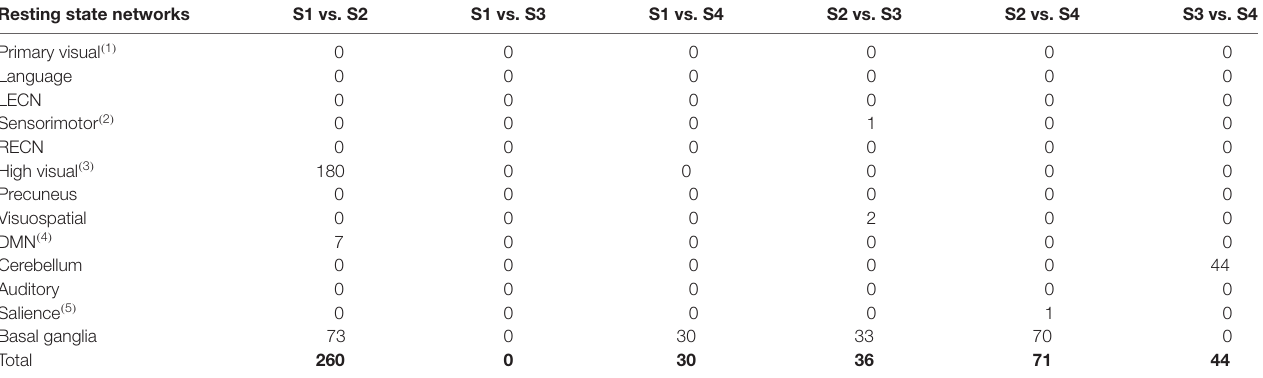
TABLE 6 | Voxel count for gradient-coil-noise-corrected dual regression analyses. Resting state